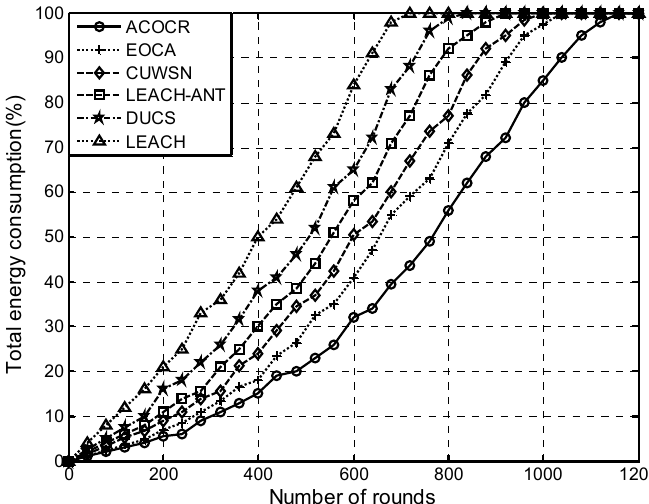
Figure 6. The total energy consumption versus the number of rounds for the six algorithms.